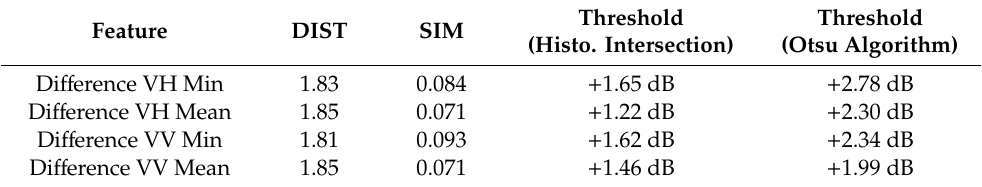
Table 2. Results of the distance (DIST) and similarity (SIM) metrics for classes “unchanged” and “changed” for time series features minimum (MIN) and mean (MEAN) in both polarization channels (VV / VH). The two metrics quantify the separation between the frequency distributions of both classes (see Figure 7). Higher DIST values and lower SIM values indicate a better separation between the classes. The last two columns show the thresholds estimated by the histogram intersection and by the Otsu Algorithm. Threshold Threshold Feature DIST SIM (Histo. Intersection) (Otsu Algorithm) Di ff erence VH Min 1.83 0.084 + 1.65 dB + 2.78 dB Di ff erence VH Mean 1.85 0.071 + 1.22 dB + 2.30 dB Di ff erence VV Min 1.81 0.093 + 1.62 dB + 2.34 dB Di ff erence VV Mean 1.85 0.071 + 1.46 dB + 1.99